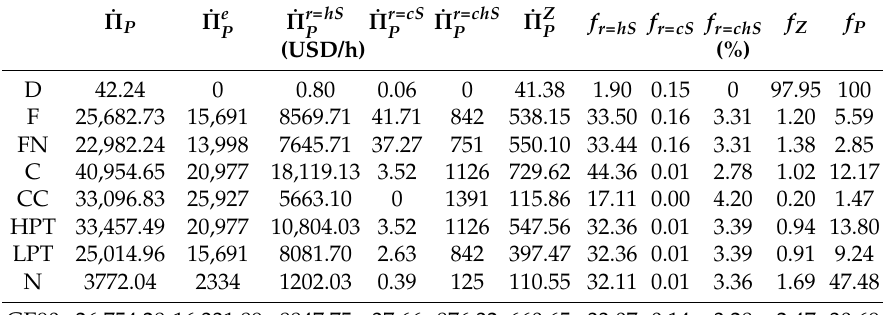
Table A3. Product exergoeconomic cost decomposition: Π P = Π e